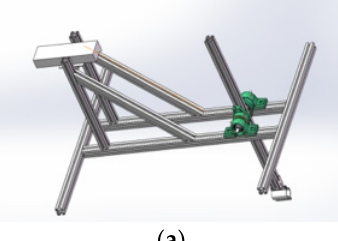
Figure 18. The experimental and simulation results ( a ) and error assessment ( b ) of S-AUG ( V = 0.4 m/s; Error = (EFD − CFD)/CFD × 100%).